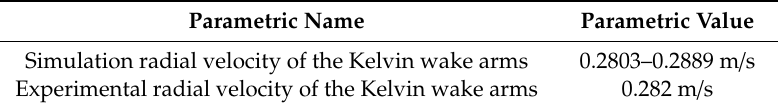
Figure 12. Kelvin wake radial velocity image. Table 2. Simulation and experimental radial velocities of the Kelvin wake